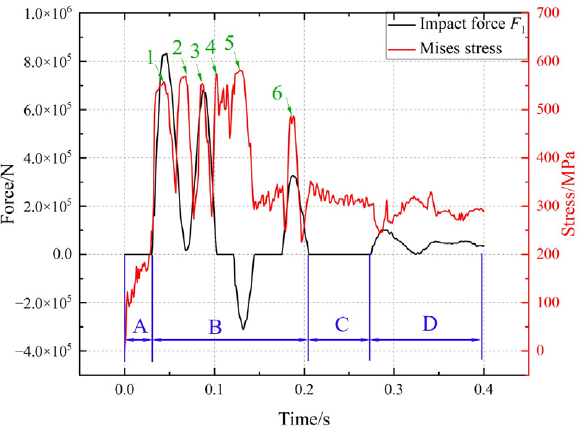
Figure 21. The variation of the maximum Mises stress of the frame over time.